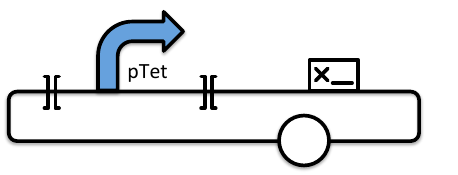
Figure 30: Promoter pTet stored in a circular plasmid, flanked by blunt-ended restriction sites. In addition, the plasmid has been bar-coded with a signature and has its origin of replication marked.